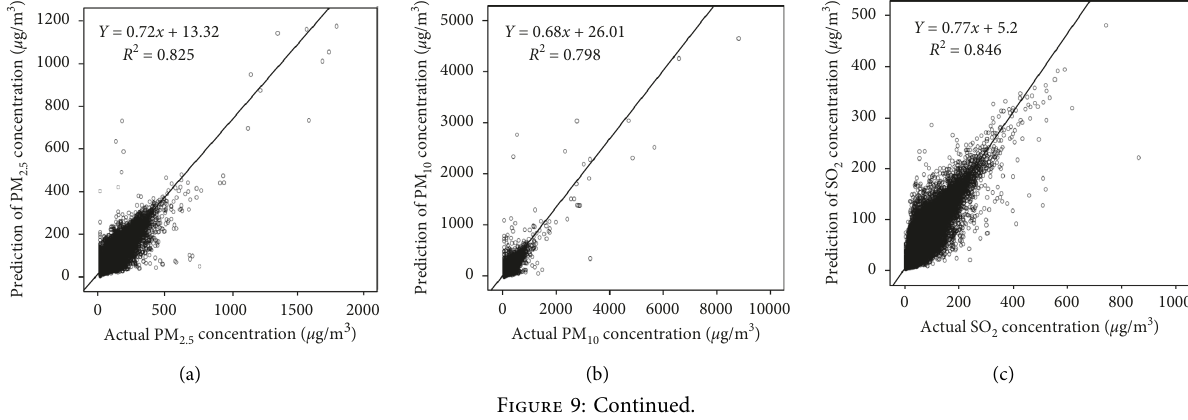
Figure 8: Spatial clustering of the importance of the impact of meteorological factors on the AQI.